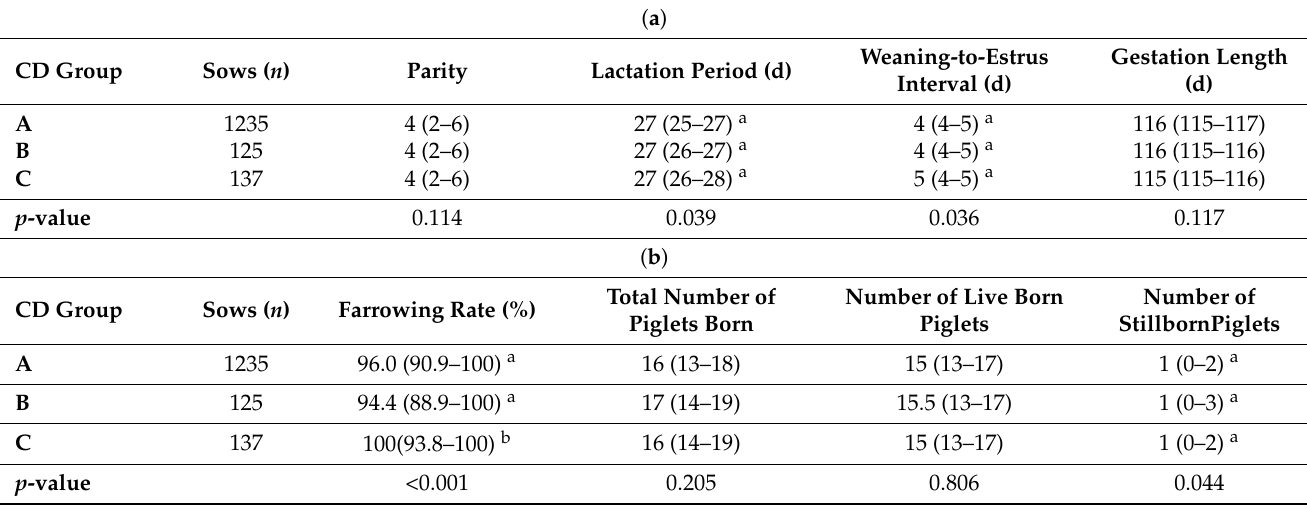
Table 3. Sow-related factors ( a ) and fertility data ( b ) regarding the three different levels of cytoplasmic droplet (CD) rates in the semen used for insemination: A: low (<10%), B: moderate ( ≥ 10 and <15%) and C: high ( ≥ 15%). Values are shown as median (interquartile range). Significant differences between the groups are marked by different superscript index letters (a,